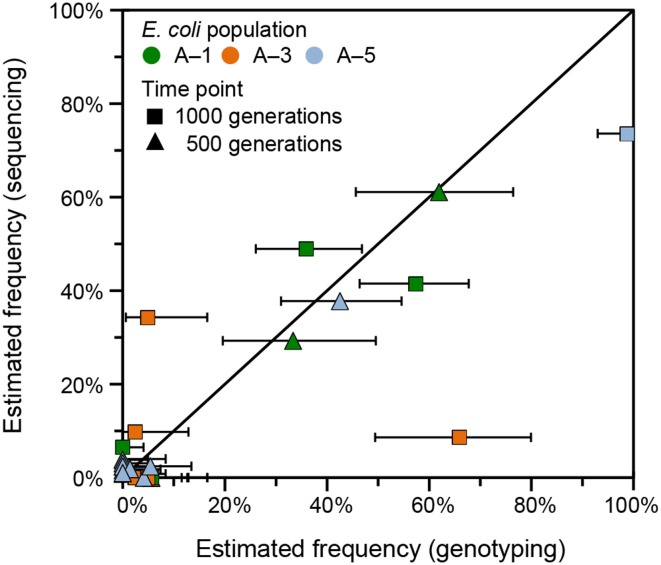
Comparison of junction frequencies determined by genotyping and whole-population sequencing. Deletions of various sizes extending from an IS150 element into the adjacent ribose utilization operon are common in the LTEE. Each deletion generates a new variant junction. This plot compares the results of using polymorphic junction predictions in breseq and genotyping randomly picked clones to estimate the frequencies of the various deletion alleles of different sizes detected in three of the LTEE populations. Horizontal error bars are 95% exact binomial confidence intervals determined from the numbers of clonal isolates genotyped with and without a given ribose deletion allele. Estimation error in the vertical direction is likely of a similar magnitude, but it is difficult to estimate due to the nested nature of the ribose deletions (see Materials and Methods).